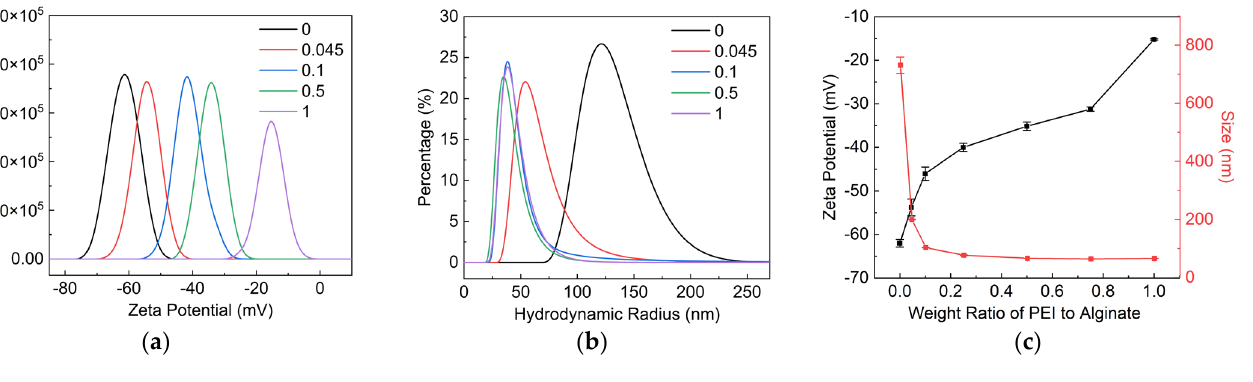
( d ) Figure 4. AFM characterization of CNO nanosheets transferred from ( a , b ) CNO/SA and ( c , d ) CNO/SA/PEI dispersion (the weight ratio of PEI to SA is 0.045).